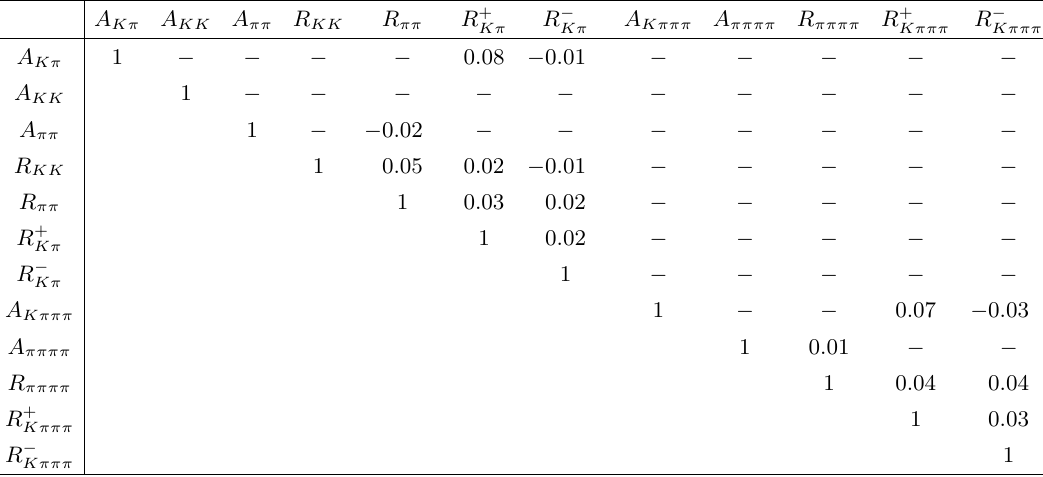
Table 3. Correlation matrix of the statistical uncertainties for the twelve physics observables from the simultaneous (cid:12)t to data. Only half of the symmetric matrix is shown.